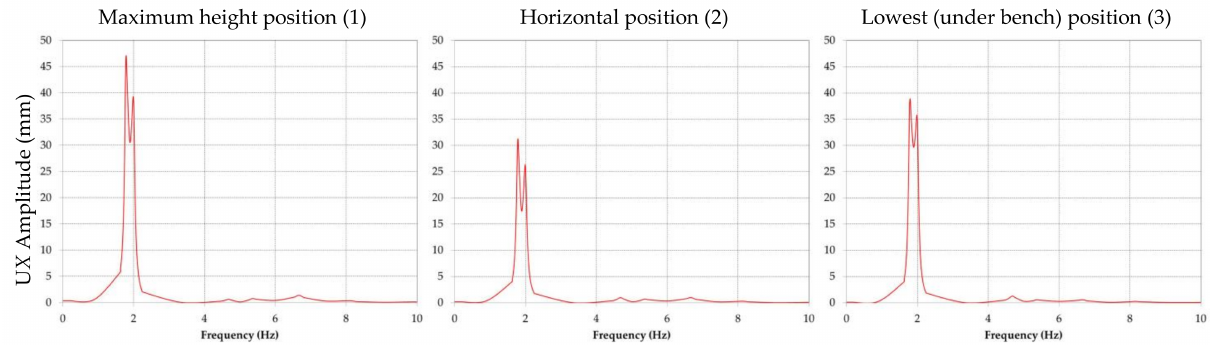
Figure 13. Comparative results of the amplitude of the displacement in direction X for positions (1), (2) and (3) of the BWE boom.